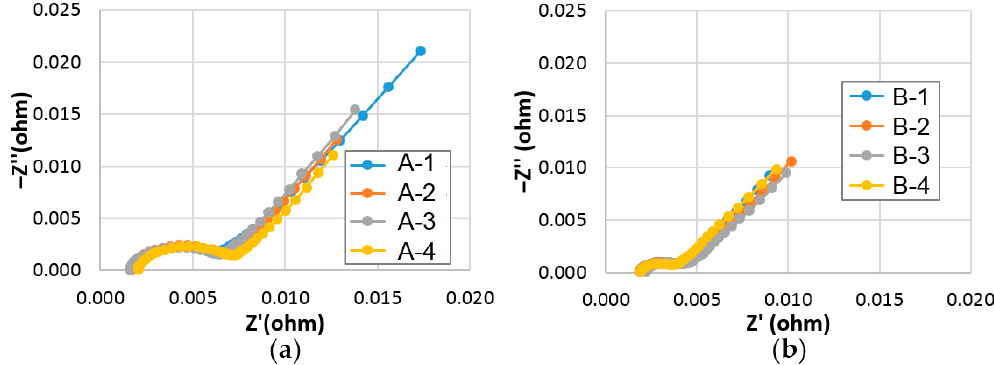
Figure 9. Cole–Cole plots of ( a ) cell A (set of four), and ( b ) cell B (set of four) measured at room temperature.